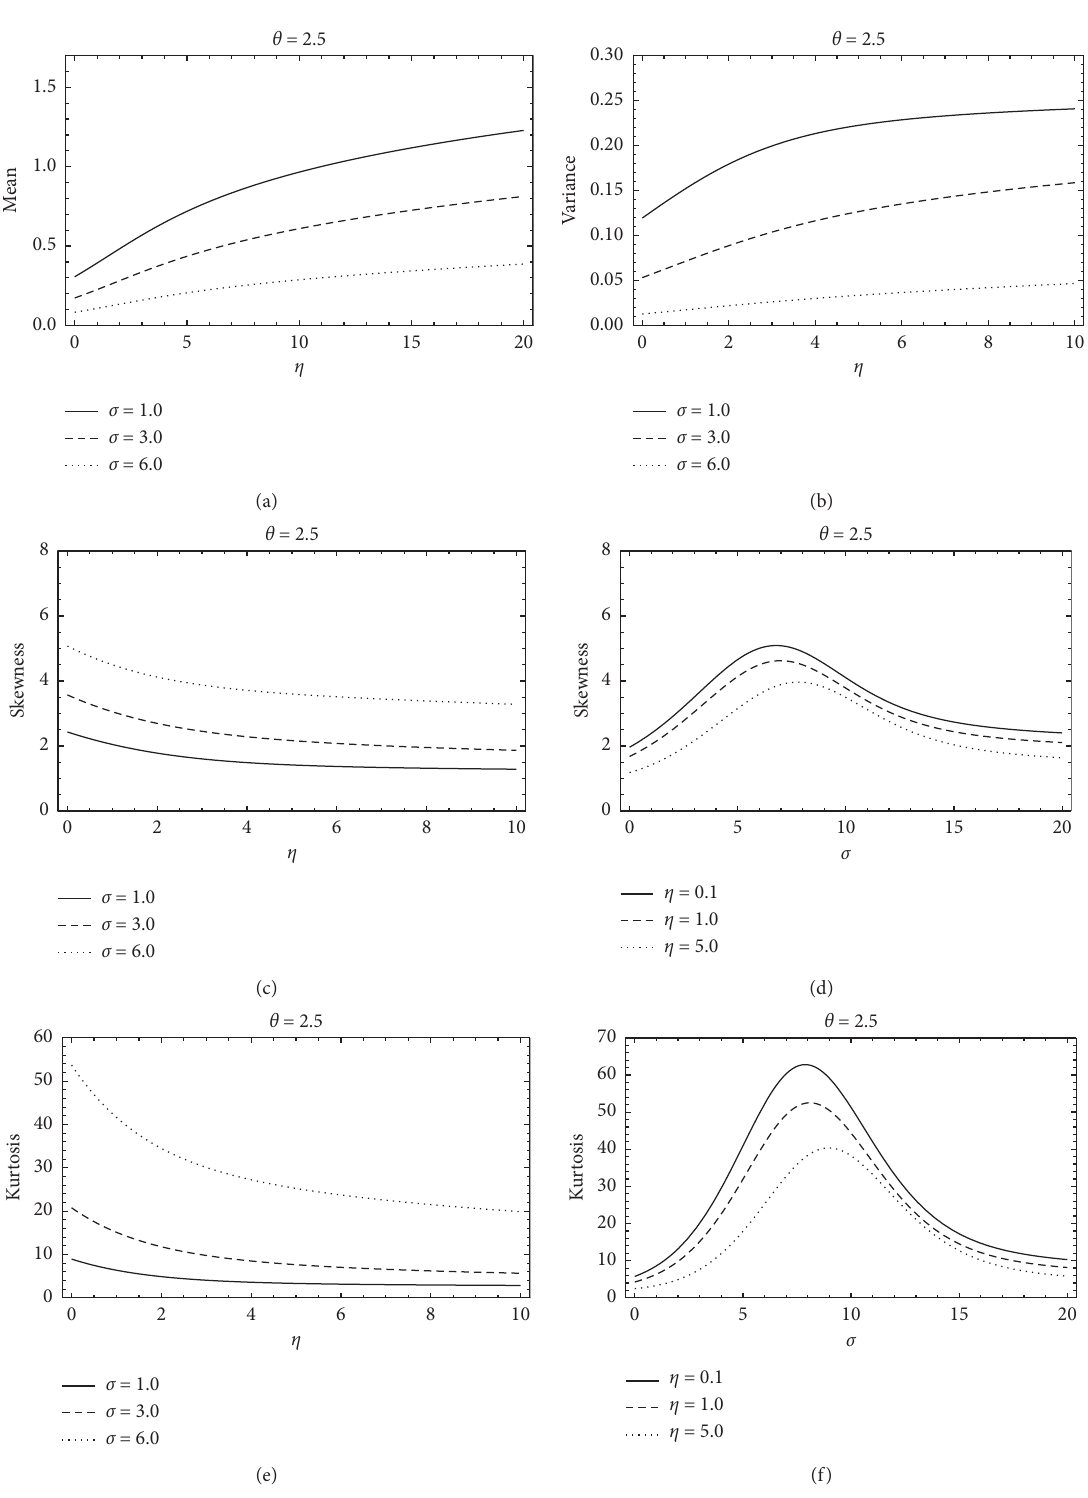
Figure 4: The mean, variance, skewness, and kurtosis of the